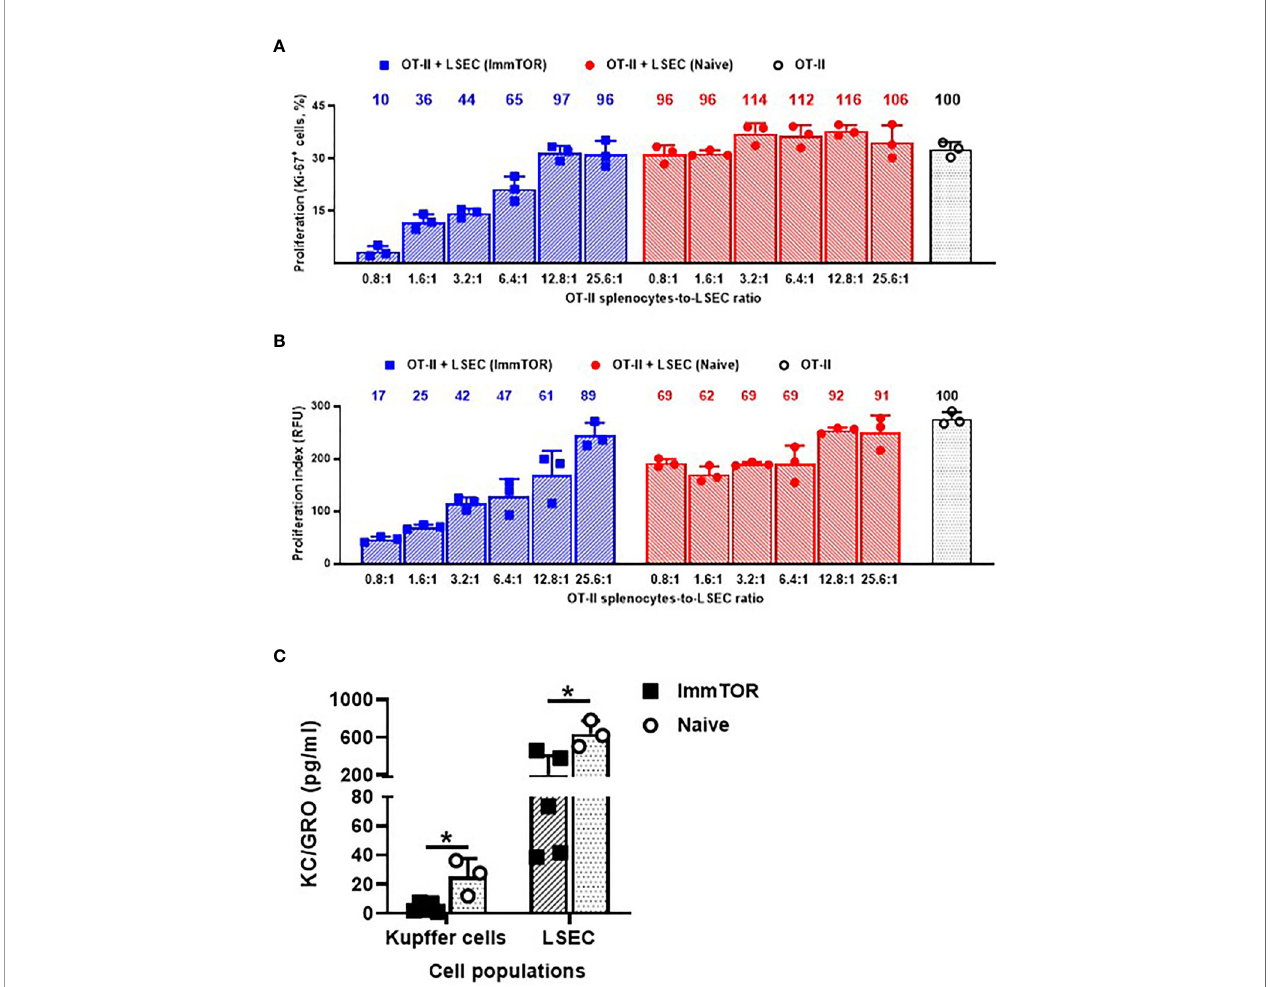
FIGURE 7 | LSEC from ImmTOR-treated mice inhibit T cell proliferation in vitro and together with Kupffer cells, exhibit diminished KC/GRO secretion. LSEC were isolated from ImmTOR-treated (300 µg, 7 days) and intact animals and co-incubated at limiting dilutions with splenic derived OT-II cells and OVA 323-339 (1 µg/ml). Cell proliferation index was measured by the percentage of Ki-67-positive cells (A) or by intensity of PrestoBlue fl uorescent staining (B) as described in Materials and Methods with relative proliferation at each LSEC-to-splenocyte ratio also shown vs. positive (no LSEC) OT-II control as 100%. Experiment was performed twice with the same outcome and representative results are shown. (C) – LSEC and KC were puri fi ed from ImmTOR-treated (7 days) and intact animals, their purity con fi rmed by FACS and then were plated at 200,000 cells/well with cytokine concentration in supernatants assayed at 7 days. Levels of KC/GRO secretion are shown with statistical signi fi cance indicated (* – p<0.05; Mann-Whitney